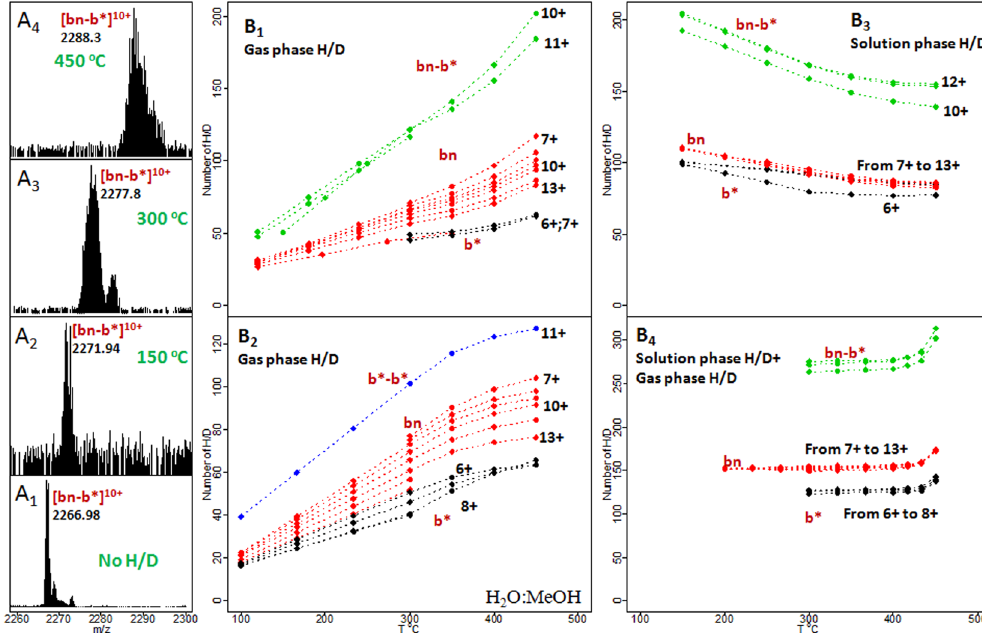
Figure 2. H/D exchange experiments. ( A 1 – A 4 ) – mass shift of [bn-b * ] 10 + as a function of the temperature of the desolvating capillary. The average m/z of the isotopic cluster is shown. ( B 1 ) shows the number of exchanges in the gas phase H/D exchange reaction. ( B 2 ) - the number of exchanges for the gas phase H/D exchange in a H 2 O:MeOH solution. ( B 3 ) - the number of exchanges in case of an in solution H/D exchange reaction. ( B 4 ) - the number of the exchanges under the combined solution plus gas phase H/D exchange conditions. Black numbers show the charge state of the corresponding ion shown in red. Lines: green – bn-b * complex, red – bn, black – b * , blue – b * -b * complex observed for a H 2 O:MeOH